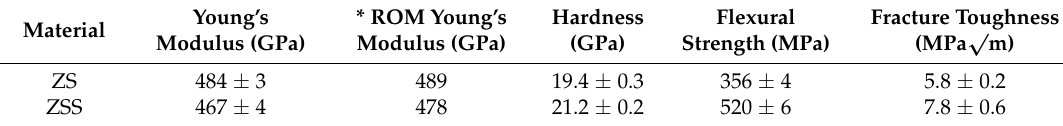
Table 2. Biaxial principal residual stresses, σ 1 and σ 2 , and maximum residual shear stress, τ max , present in the selected phases of oxide scales of ZS and ZSS subjected to cyclic oxidation at 1300 ◦ C. Values of stress calculated from Equation (5) are also shown for